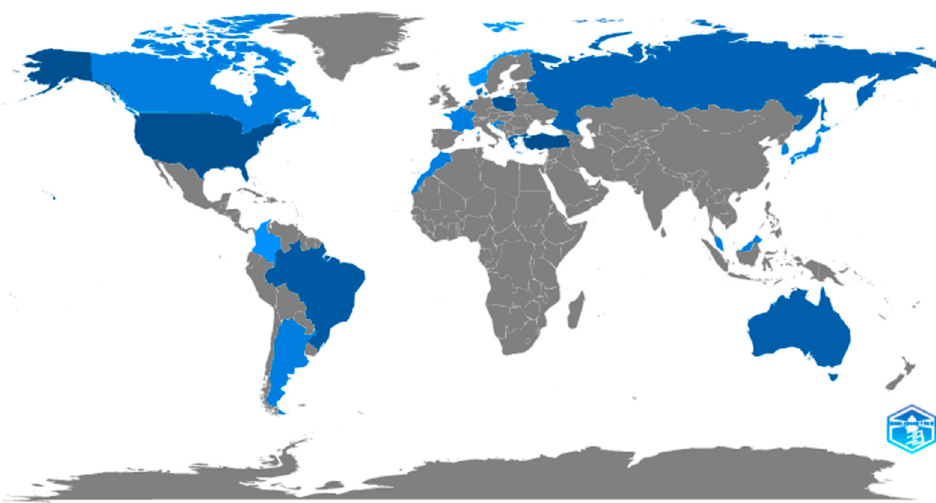
Figure 8. Scientific production by country related to the term “marine cadastre”.